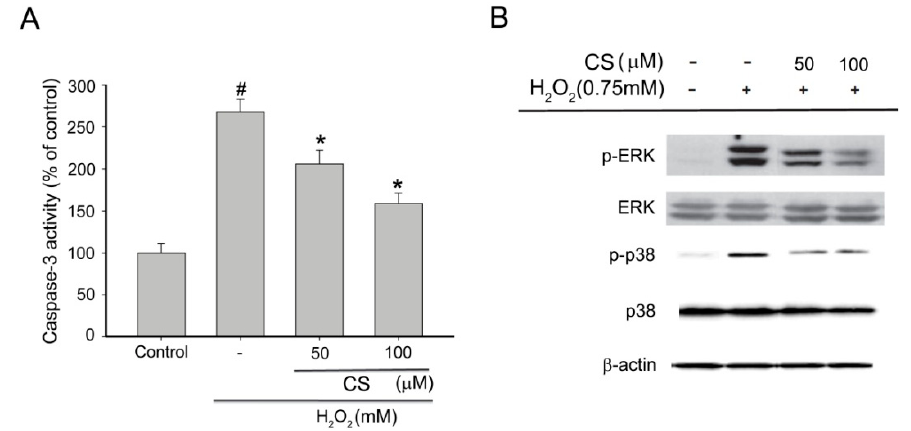
Figure 5. Effect of costunolide (CS) on H 2 O 2 -induced apoptosis in PC12 cells. PC12 cells were pretreated with various concentrations of MCG for 30 min before exposure to 0.75 mM H 2 O 2 for 6 h. ( A ) The effect of CS on caspase-3 activity in H 2 O 2 -induced PC12 cells. Cells were pretreated with various concentrations of CS for 30 min before exposure to 0.75 mM H 2 O 2 for 6 h. Caspase-3 activity was determined using a commercial kit according to the manufacturer’s instruction. Values with the same color bars with the same superscript letters are not significantly different from each other at # p < 0.01 compared with the control group; * p < 0.05, compared with the model group; ( B ) Following the same treatment, the levels of phospho- or total mitogen activated protein kinases (MAPKs) (ERK and p38) were identified by their antibodies. Results are representative of three experiments.